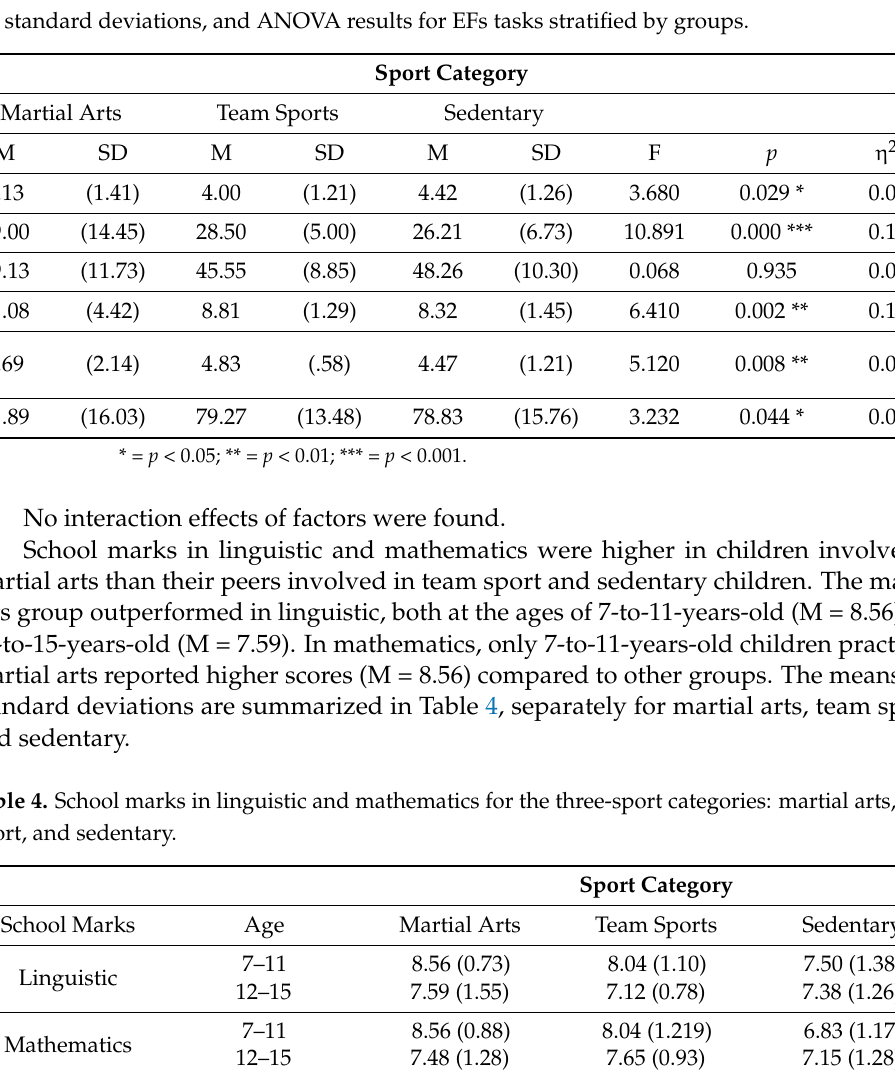
Table 3. Means, standard deviations, and ANOVA results for EFs tasks stratified by groups.